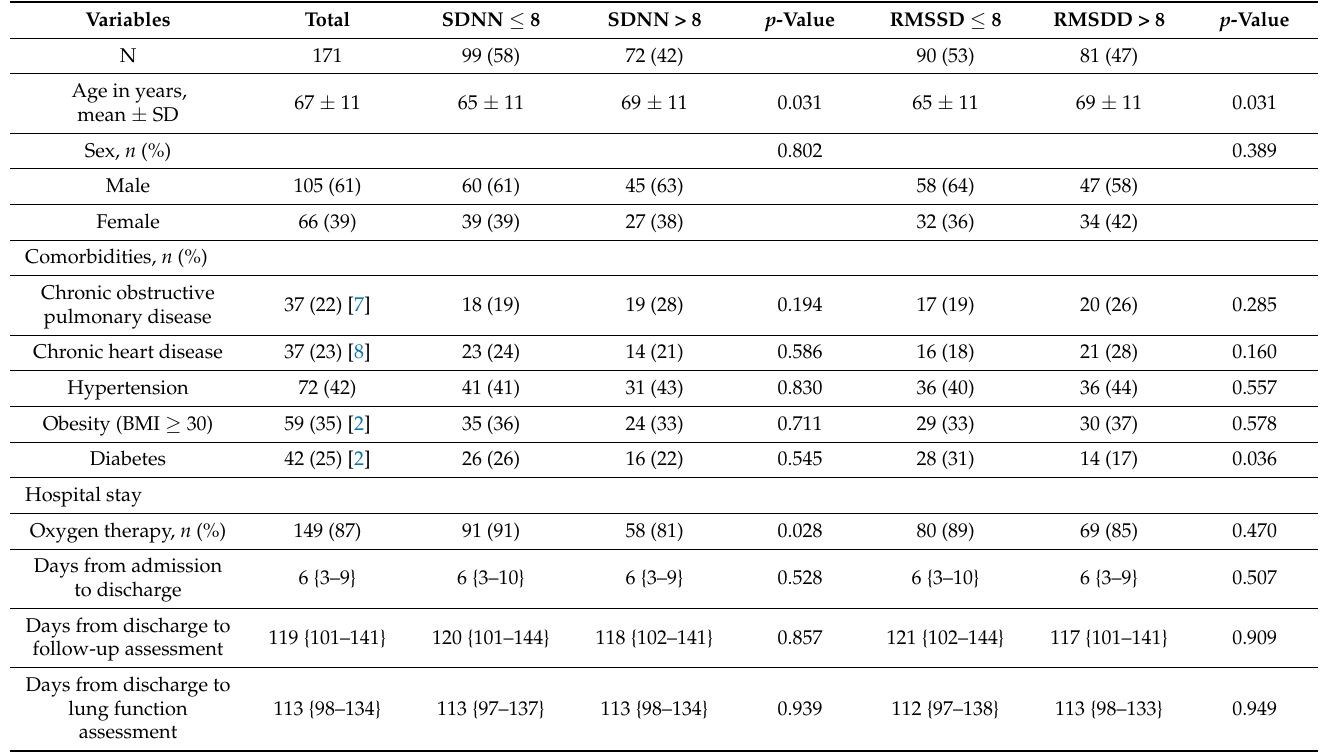
Table 1. Descriptive data of included patients according to heart rate